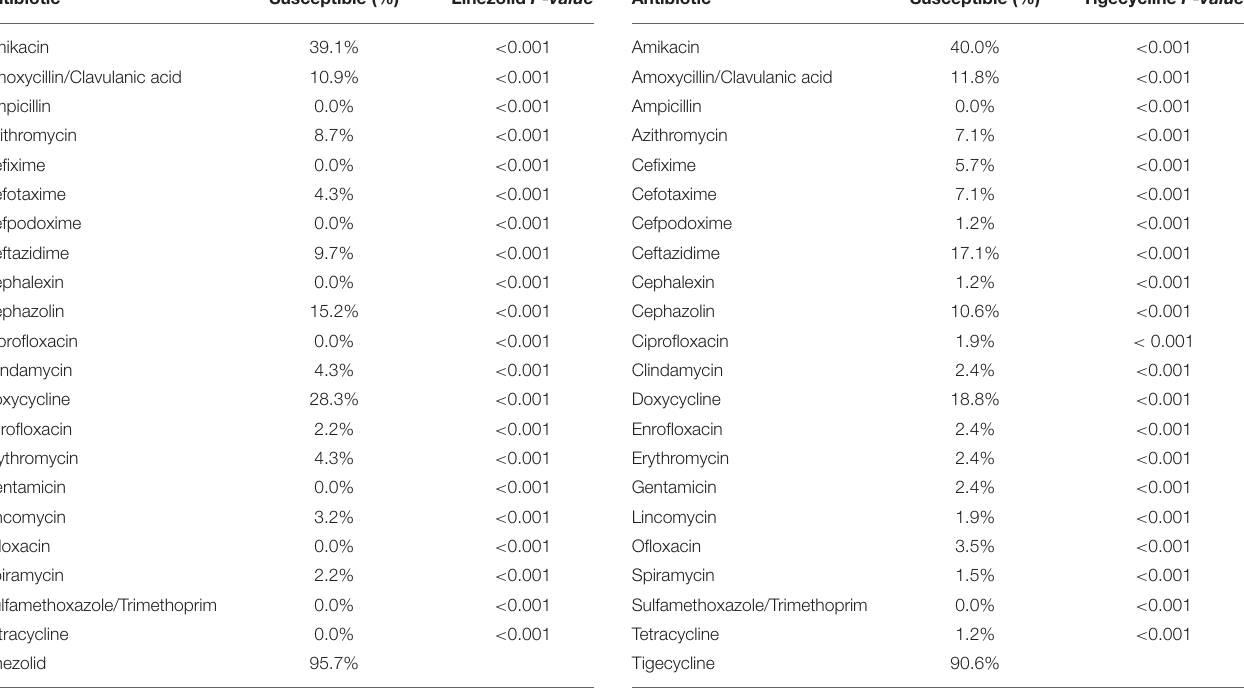
TABLE 3 | Superiority of linezolid efficacy over 21 different antibiotics to eradicate potential pan-drug-resistant bacteria from dogs. Antibiotic Susceptible (%) Linezolid P-value Amikacin 39.1%